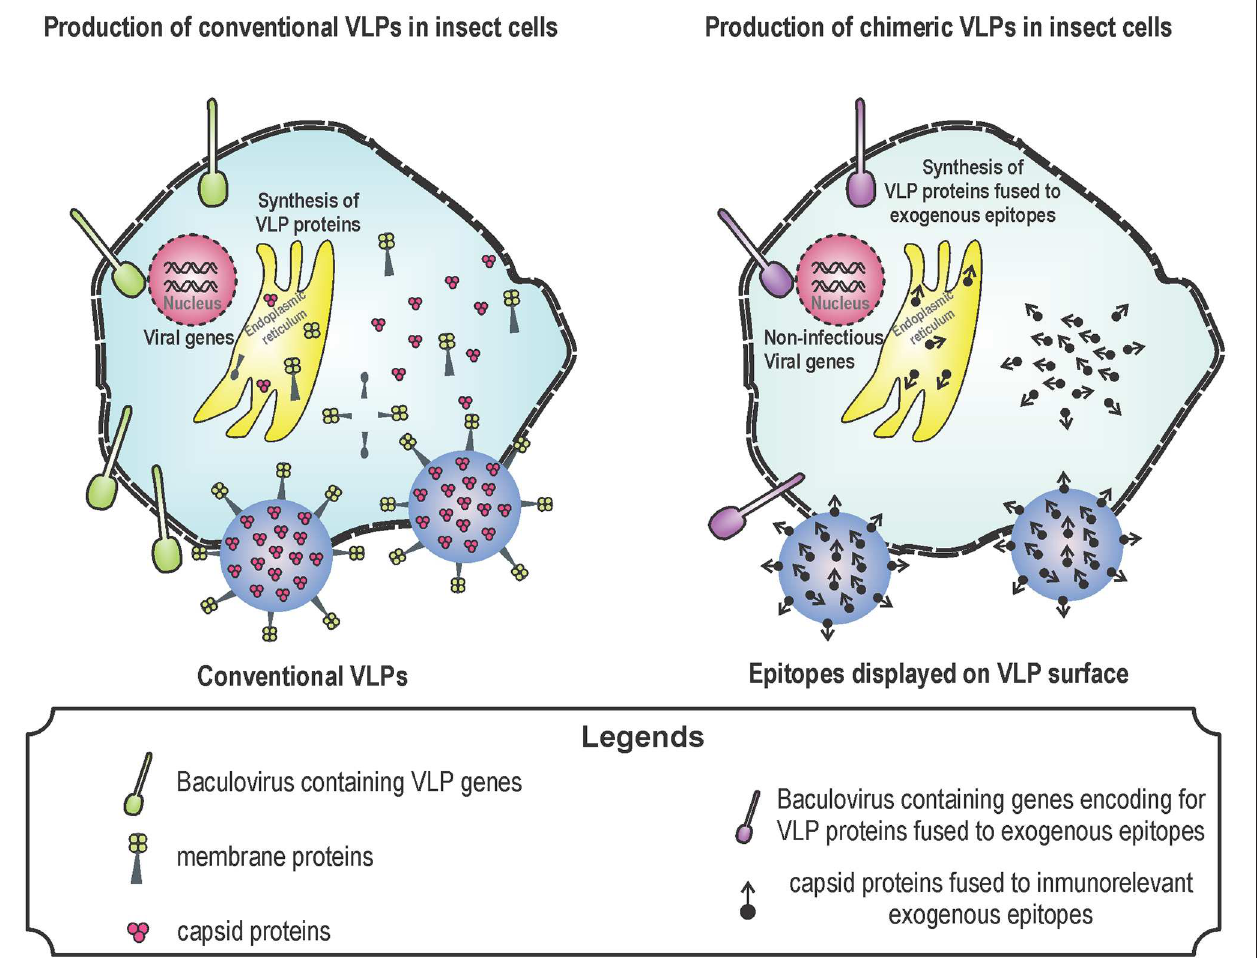
FIGURE 1 | Production of virus-like particles (VLPs) in baculovirus system. Baculovirus system is one of the most used for the production of VLPs. The design of VLPs is based on the expression of viral proteins that self-assemble by using genetically modified baculoviruses. These proteins are produced during the infection of insect cells with the recombinant baculoviruses. Baculovirus infection induce the expression of VLP proteins, VLPs are formed by means of self-assembly and VLPs together with baculoviruses leave the cell through lysis or budding. Conventional (left) and chimeric (right) VLPs can be produced for several uses: vaccine against pathogens in the case of conventional VLPs; and vaccines against cancer or allergy in the case of chimeric vaccines.